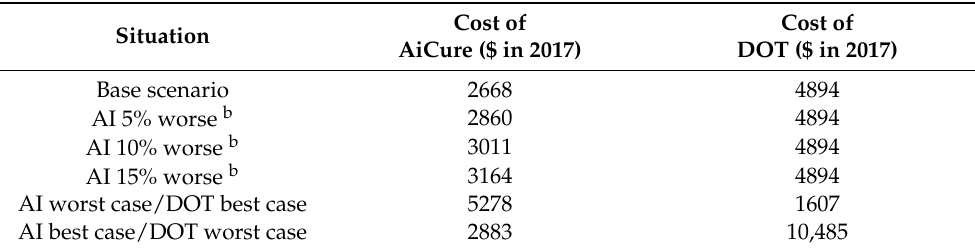
Table 2. Findings from the AiCure vs DOT study on Tuberculosis Monitoring for various scenarios captured during the study. Cost of Cost of Situation AiCure ($ in